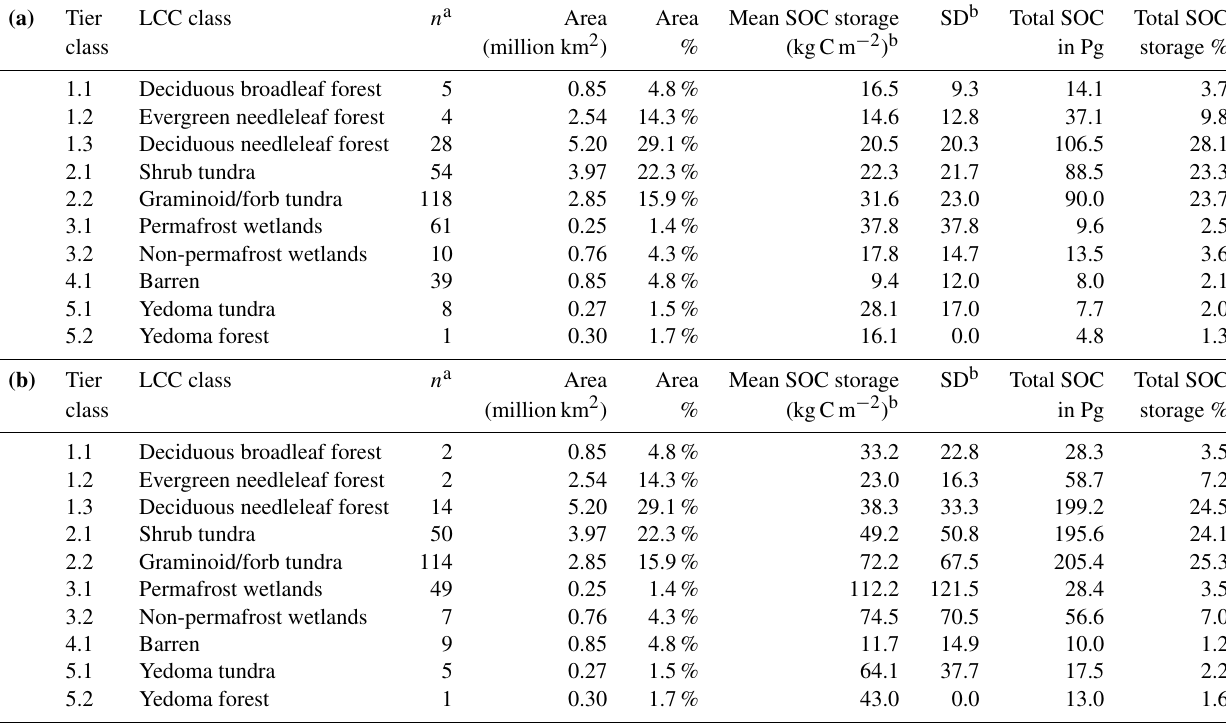
Table 5. Mean and total SOC storage for (a) 0–100cm and (b) 0–300cm soil depth separated for the different Tier classes in the northern circumpolar permafrost region, excluding water bodies and permanent snow and ice.